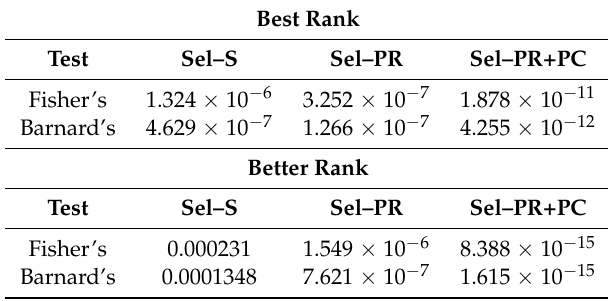
Table 7. Comparison of Size + Energy to other selection strategies on best rank via 2-sided Fisher’s and Barnard’s tests. The tests evaluate the null hypothesis (based on reported p-values) that Sel-S+E (or, Size+Energy ) provides similar ranking in comparison to other selection